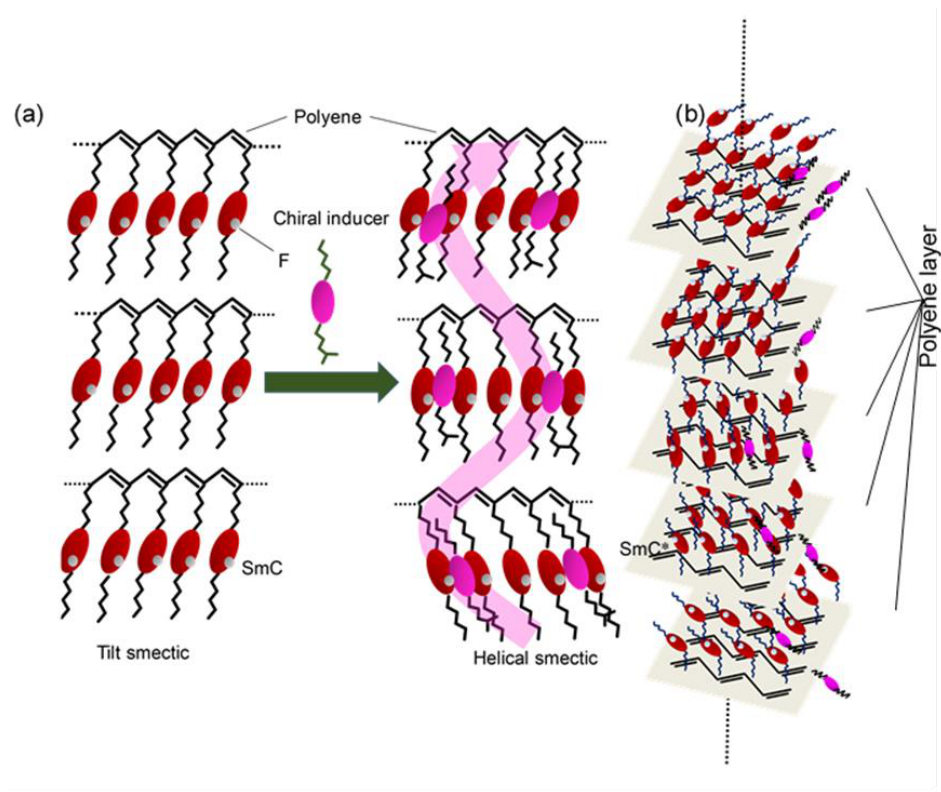
Figure 16. (a) Induction of SmC* from SmC via the addition of the chiral inducer. (b) The helical superstructure of SmC*–LC-poly(Ac–Pyr) with a polyene